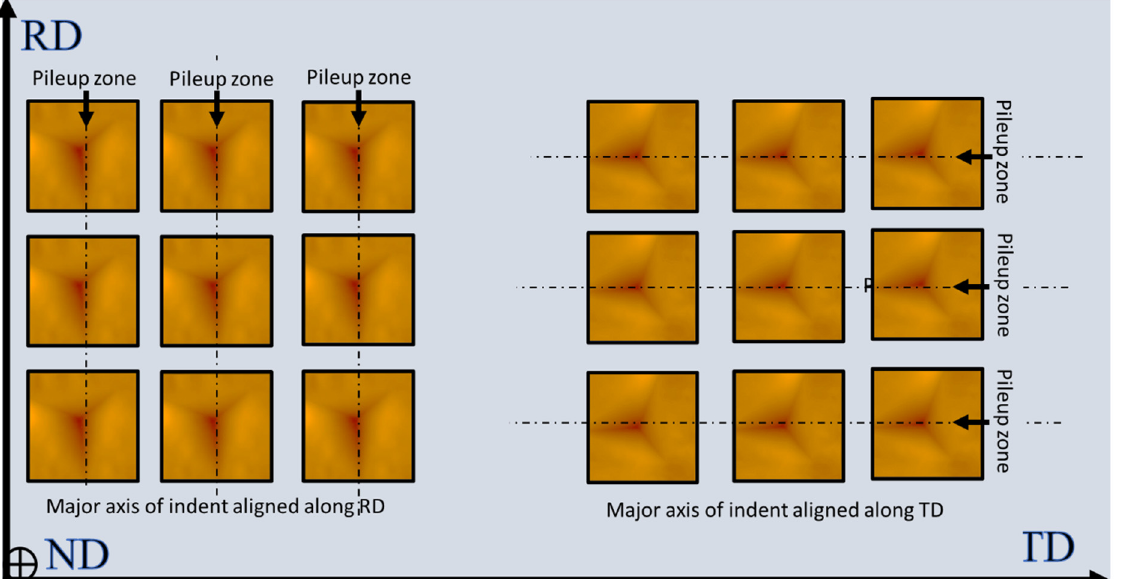
Figure 3. Schematic showing the nanoindentation performed along the RD and TD of a Cu(16)/Nb(16) ARB nanolaminate by aligning the major axis of the Berkovich tip along the TD and RD obtained using SPM. The height profiles were then plotted along the major axis of the indentations (represented as dashed lines) for RD and TD as shown in Section 3.3, and later used to measure the pile-up along these directions.